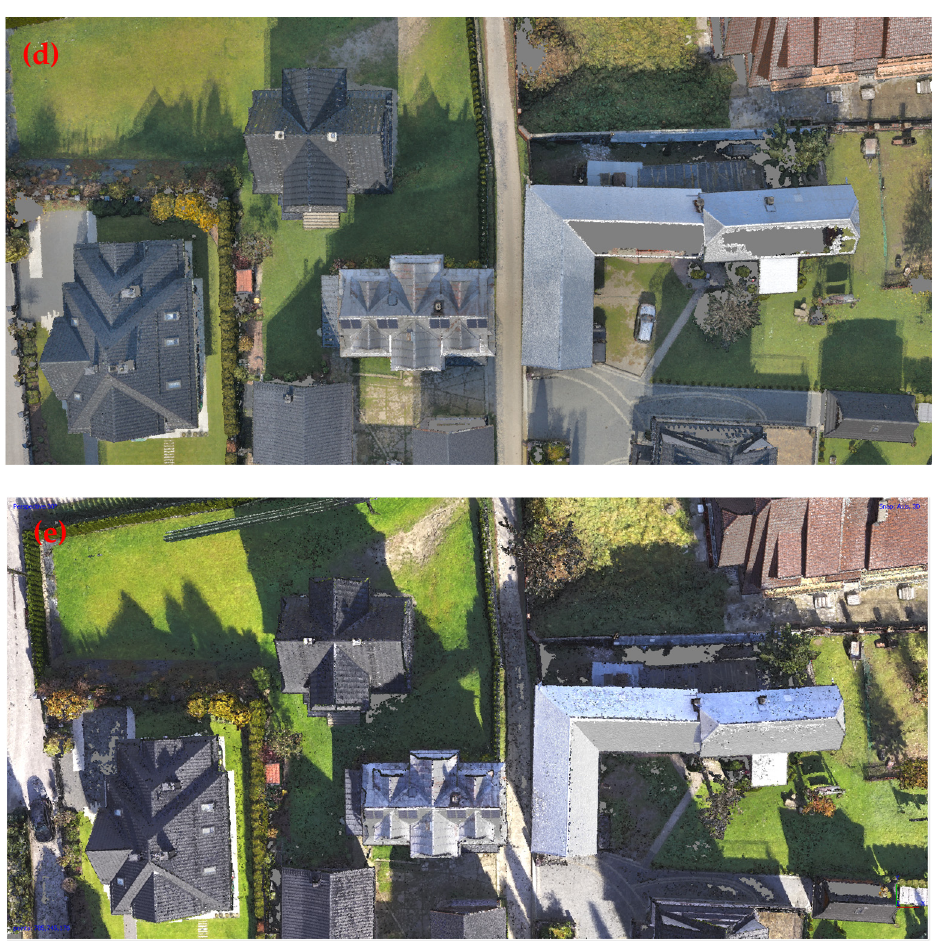
Figure 7. Missing information for roof planes in point clouds example 1 ( a ) photos of roof planes ( b ) point cloud from L1 scanner, ( c ) point cloud from DNG files, P1 camera, ( d ) point cloud from TIF files, P1 camera, ( e ) point cloud from JPG files PSDK camera.